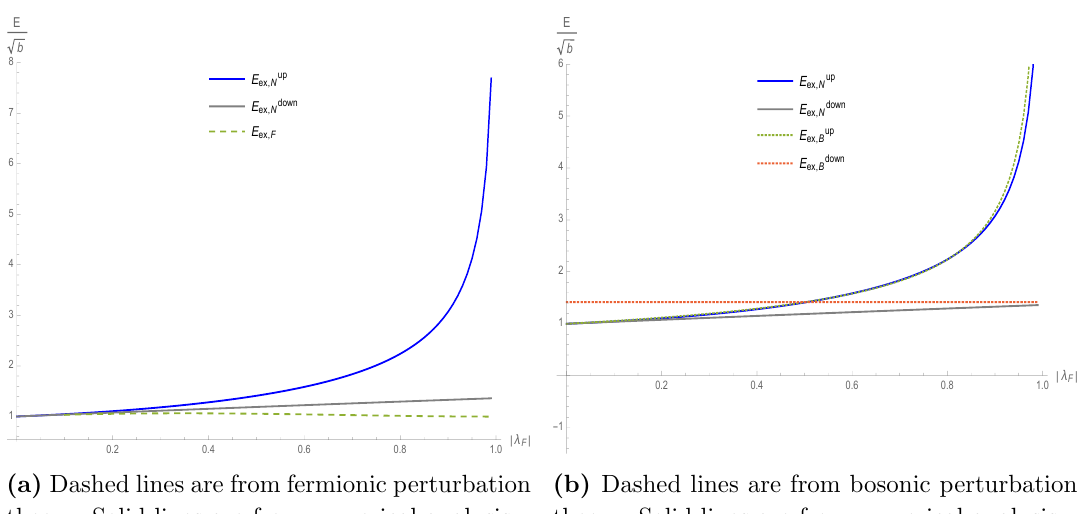
(a) Dashed lines are from fermionic perturbation theory. Solid lines are from numerical analysis. Figure 6. Exceptional energy band as a function of (cid:21) F for sgn(b (cid:21) F ) = 1, sgn(m F (cid:21) F ) = 1 at p m cri = j b j B